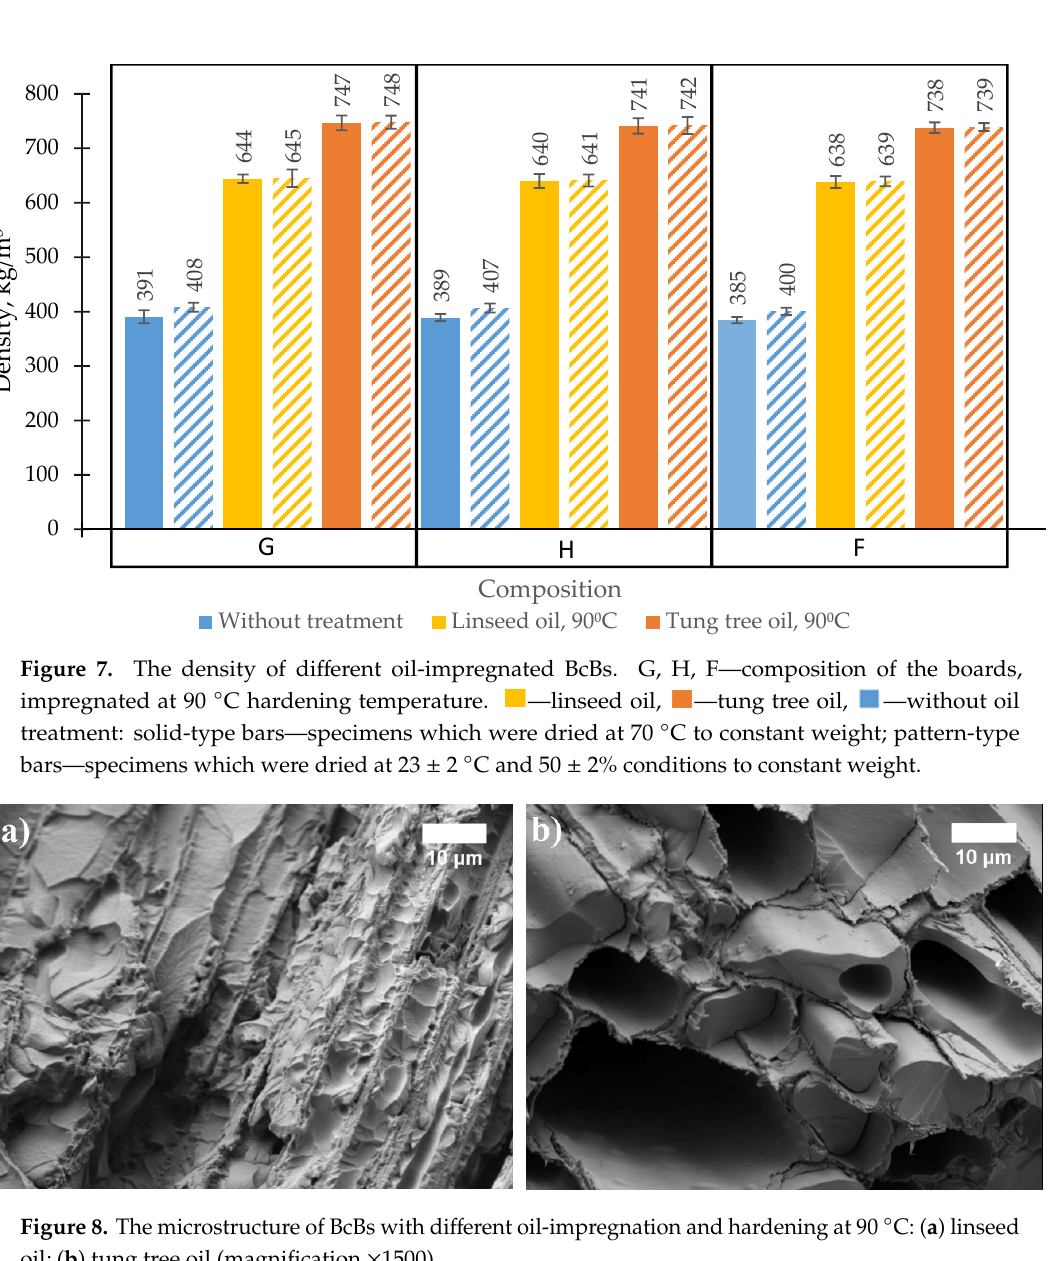
Figure 8. The microstructure of BcBs with di ff erent oil-impregnation and hardening at 90 ◦ C: ( a ) linseed oil; ( b ) tung tree oil (magnification ×